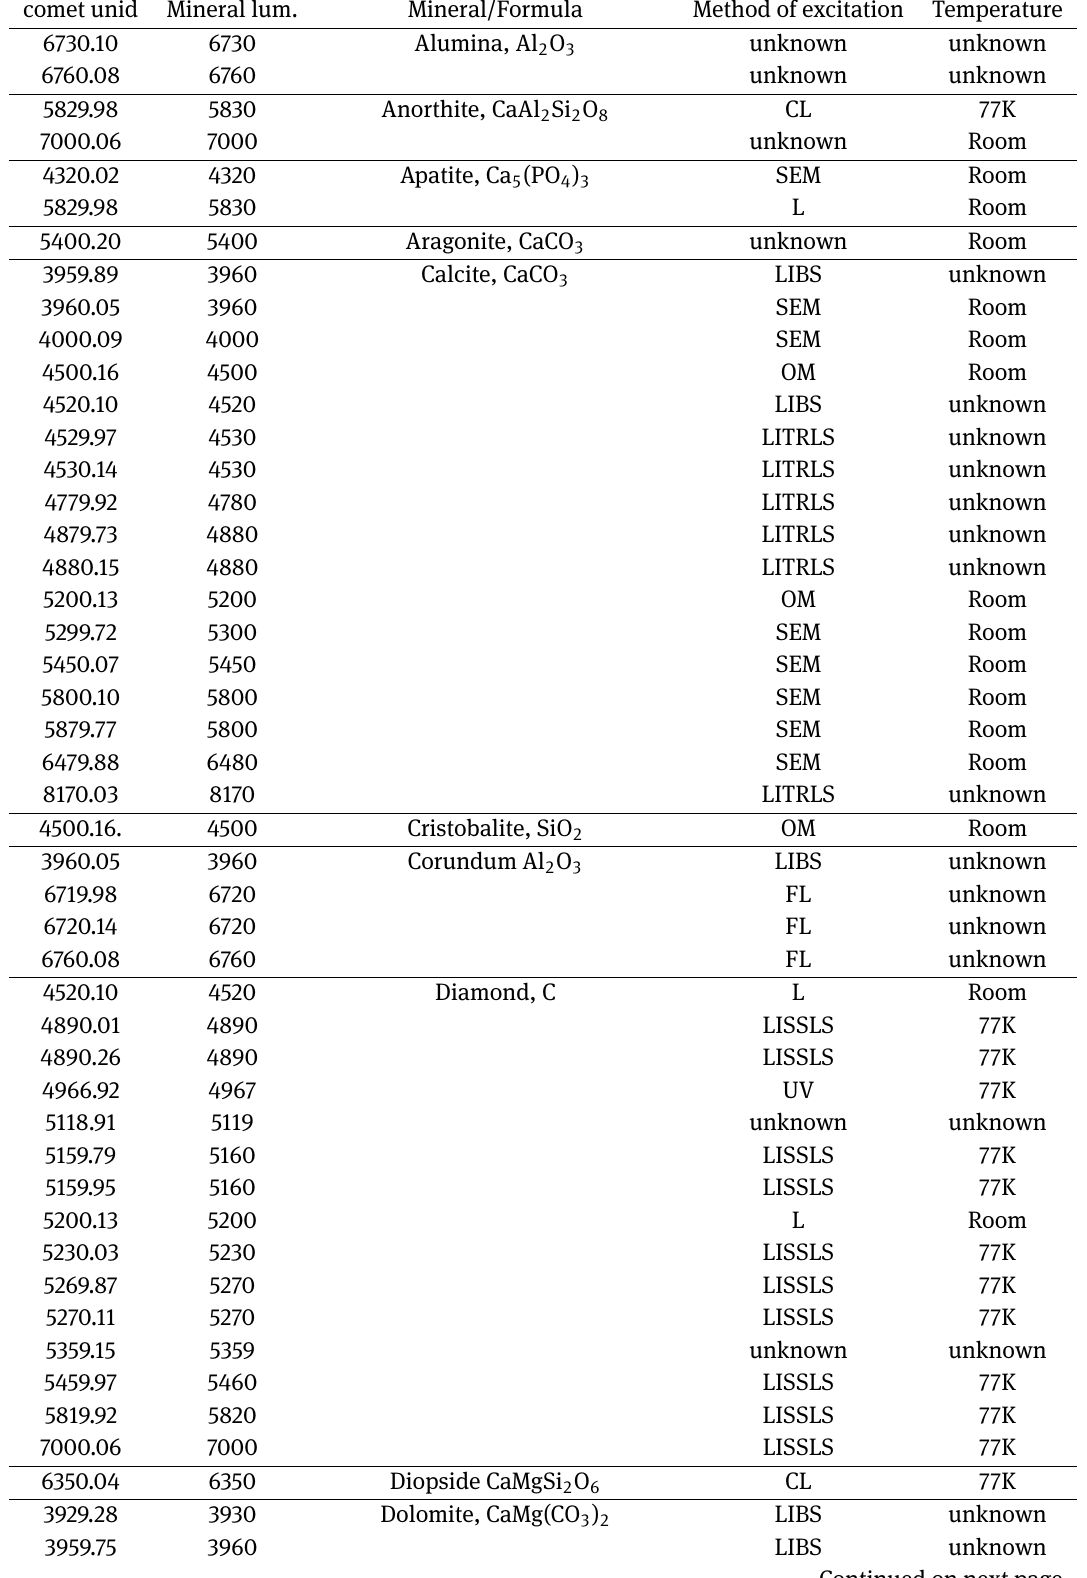
Table 2. Tentative identification of previously unknown emissions in 122P/de Vico comet spectrum. comet